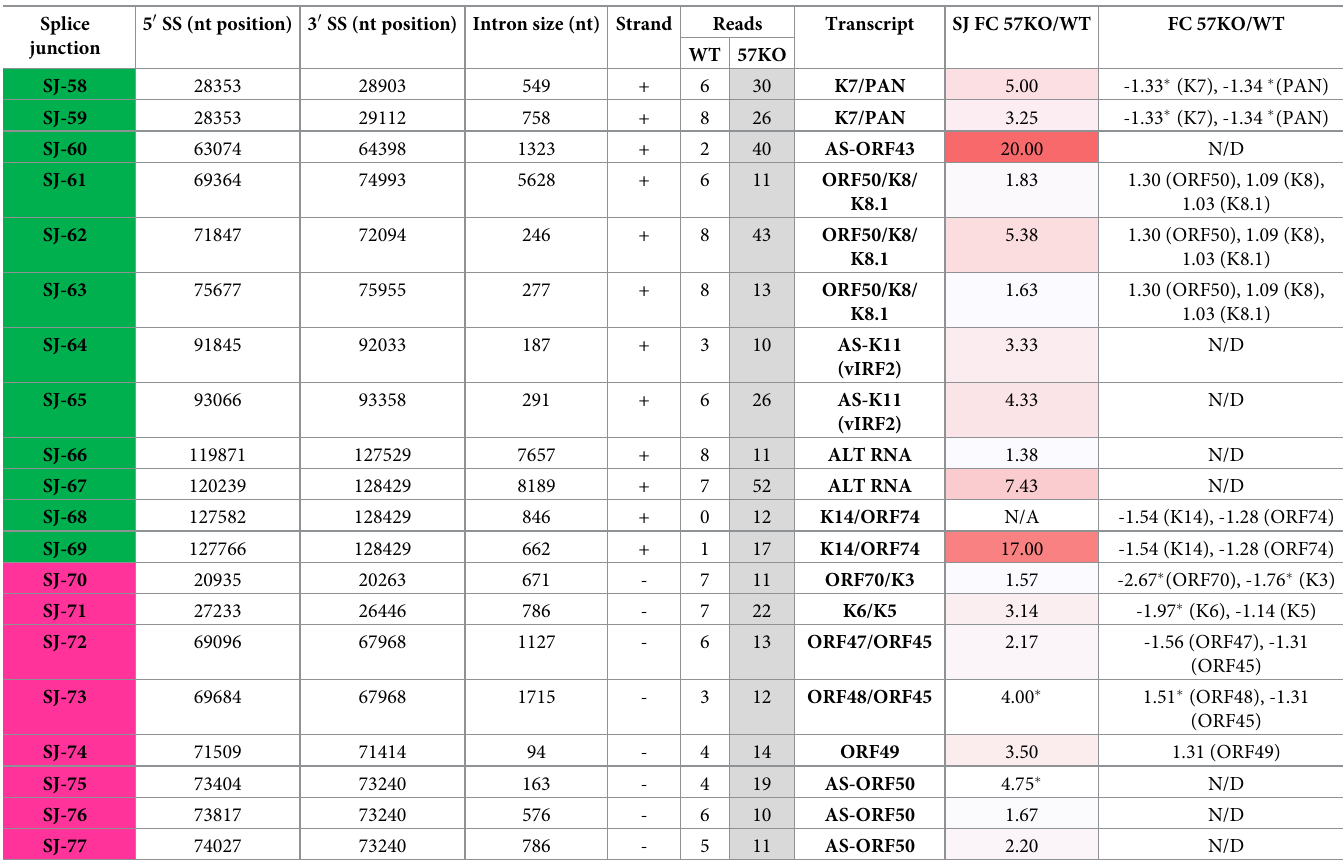
Table 3. The additional splice junctions (SJ) with � 10 splice reads detected predominantly from the 57KO genome in BCBL-1 cells. For details, see Table 1. Splice